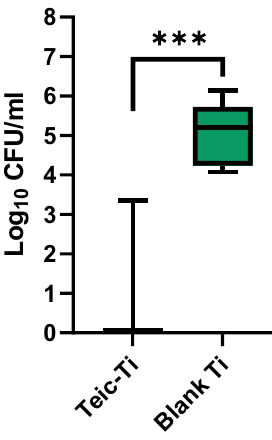
Figure 2. Antibacterial efficacy of Teic-modified Ti. Ti discs were immersed in 500 µg/ml Teic (50 mM MES; pH 5.47) for 2 h under ambient conditions. After incubation, functionalised and control discs were transferred to a new well plate, washed twice in distilled water and subsequently exposed to a 10 5 CFU/ml suspension of S. aureus in 1% Peptone/PBS for 24 h at 37 °C with gentle shaking (120 RPM). After incubation, discs were recovered, washed twice with 0.85% saline and sonicated for 5 min in 1 ml of MRD to recover attached bacteria. The detached bacteria were transferred to a new universal and incubated for 30 min at 37 °C in order to achieve maximum recovery. The recovered organisms were diluted and dispensed onto BHIA and incubated for 24 h at 37 °C. When Ti discs are steeped in a solution of Teic the modified surfaces are capable of significantly reducing bacterial attachment in comparison to the control (blank) Ti (*** p < 0.0001). All data (mean ± SD; N = 36) represent pooled triplicate runs from 12 independent